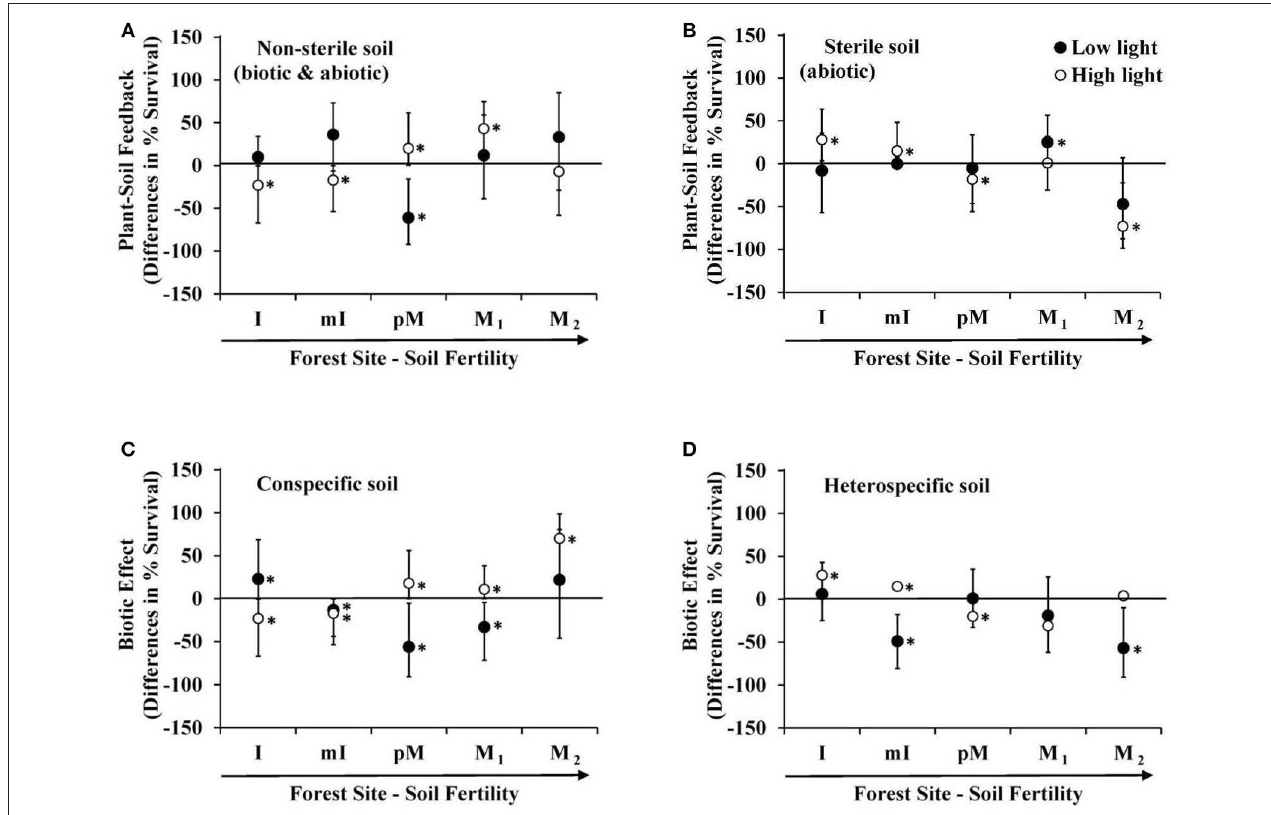
FIGURE 2 | Differences in predicted survival due to: (A) microbe + abiotic mediated PSF (survival in conspecific vs. heterospecific non-sterile soil), (B) abiotic mediated PSF (survival in conspecific vs. heterospecific sterile soil), (C) biotic effect in conspecific soil (survival in non-sterile vs. sterile conspecific soil), and (D) biotic effect in heterospecific soil (survival in non-sterile vs. sterile heterospecific soil) in a greenhouse experiment of Prunus serotina seedlings across 5 sites that range in soil fertility and community composition ( Tables 1 , 2 ) conducted under low and high light. Sites are in rank order of soil fertility from left (low) to right. Data are means with 95% credible intervals; credible intervals that do not overlap with the zero line are statistically significant. * P < 0.05.